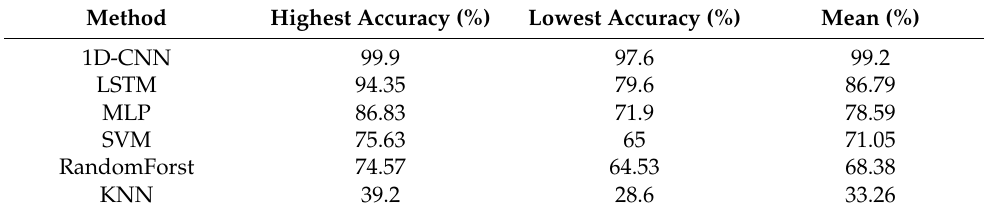
Table 3. Accuracy of six different models.